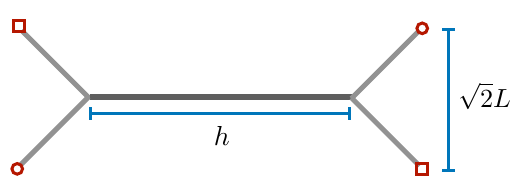
Figure 5 . The connected configuration for α = 0 . The (1,1) and (1,-1) 5-brane segments have all length L